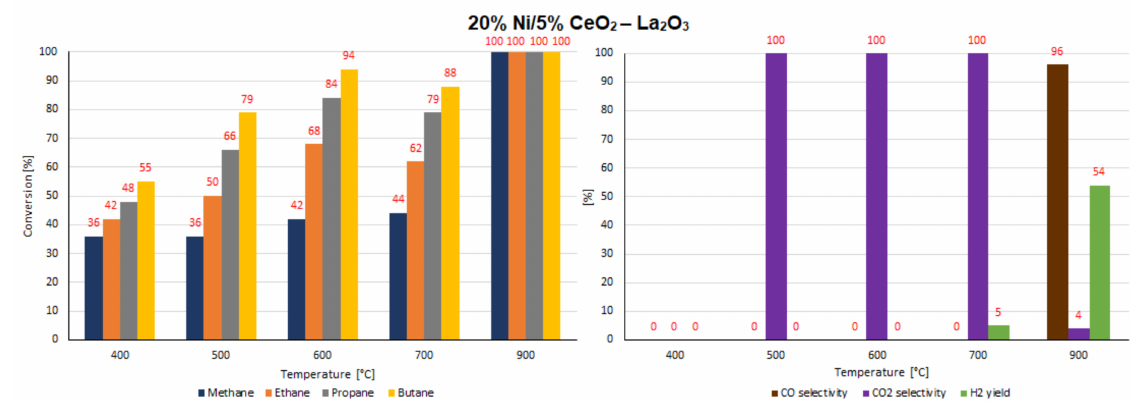
Figure 20. The activity results of the 20% Ni/5% CeO 2 –La 2 O 3 catalyst in the OSR-LNG process.